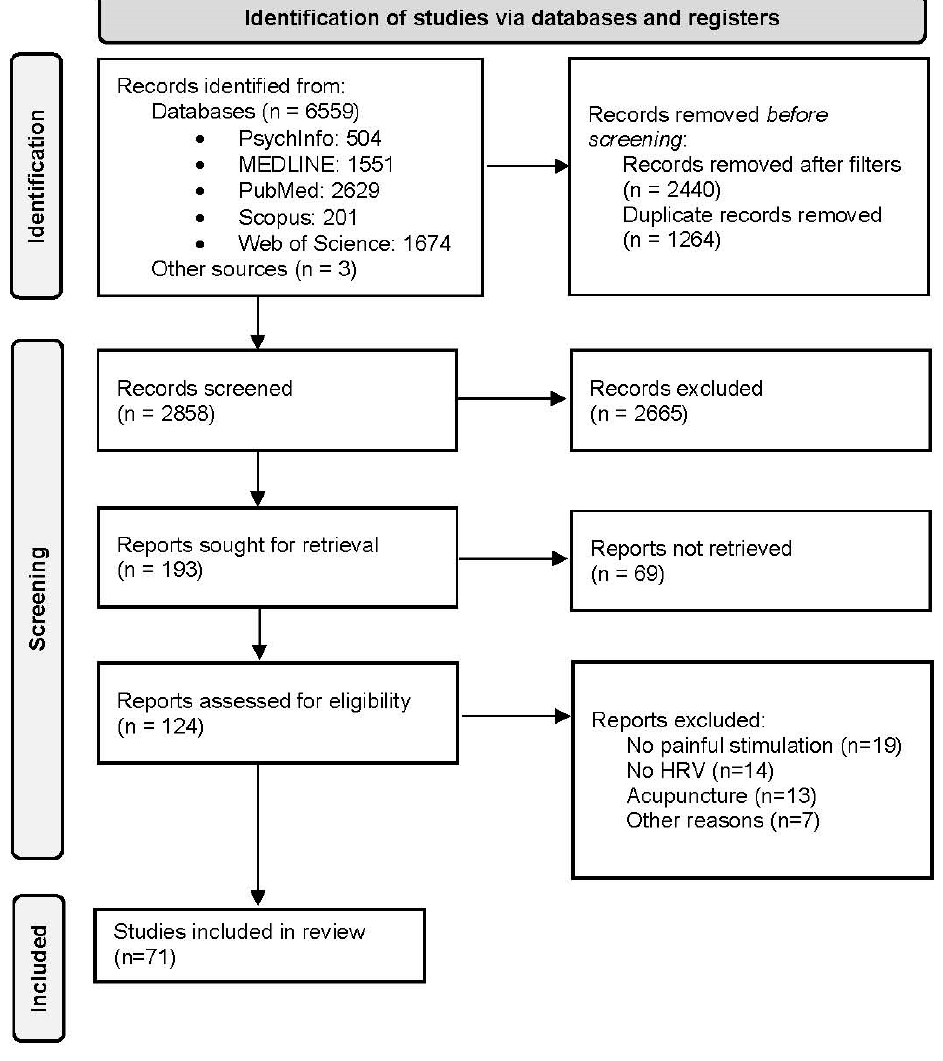
Figure 1. PRISMA flow diagram.